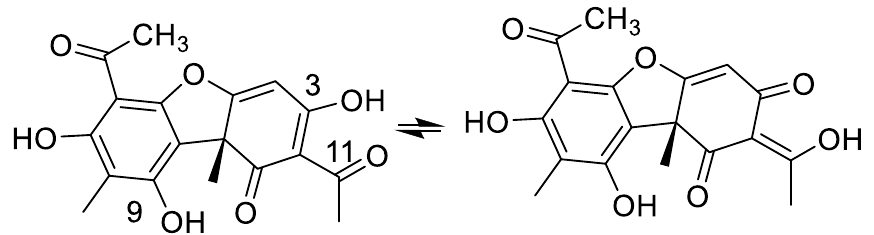
Figure 6. Tautomeric equilibrium of β -triketone type, usnic acid.